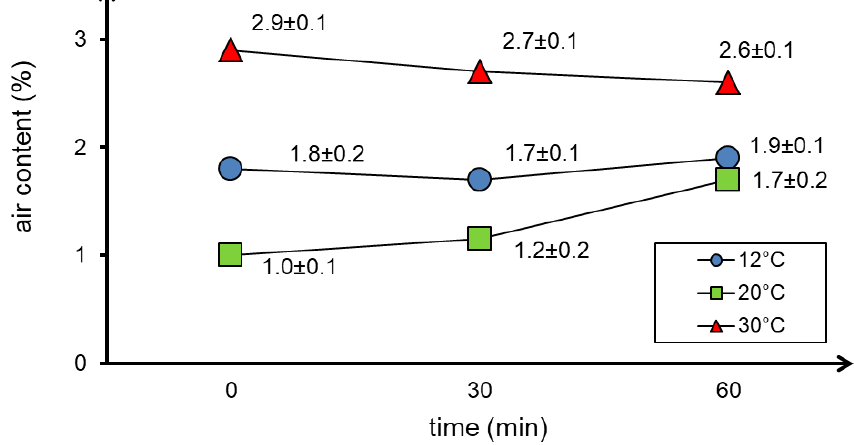
Figure 6. The results of air content tests in the concrete mixture depending on the curing temperature and